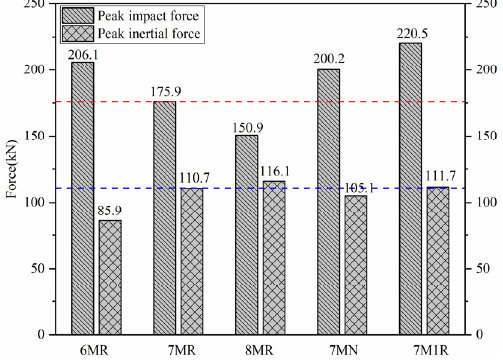
Figure 8. Peak impact load and peak inertial force.